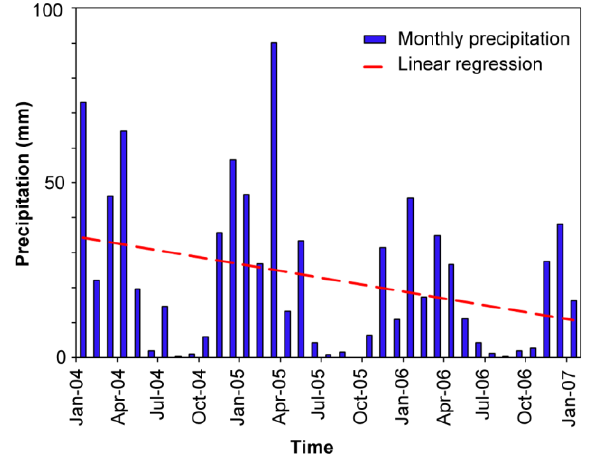
Figure 14. Accumulated monthly precipitation in Sarcheshmeh during 2004–2007